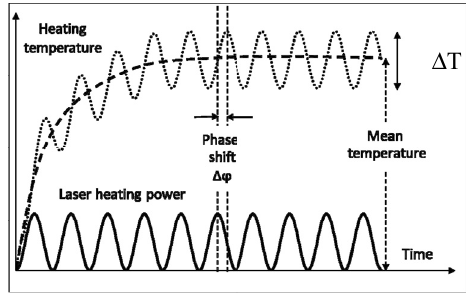
Fig. 1. Phase shift of heating